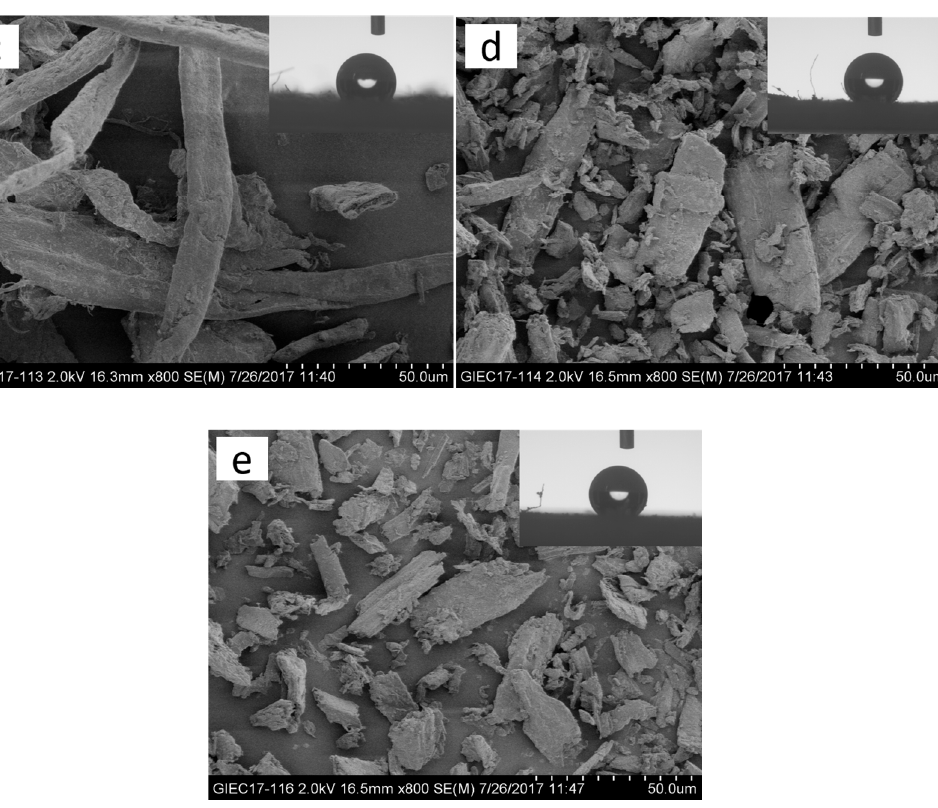
Figure 2. SEM images of ONP fibers treated with different methyltrichlorosilane (MTCS) dosages and their corresponding water contact angle photos: ( a ) 0 ( v / w ); ( b ) 2% ( v / w ); ( c ) 4% ( v / w ); ( d ) 6% ( v / w ); and ( e ) 8% ( v / w ).